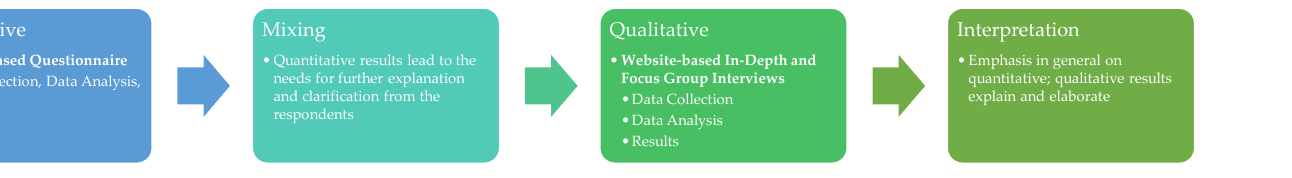
Figure 1. Mixed-method sequential explanatory research design. (adapted from [12].)